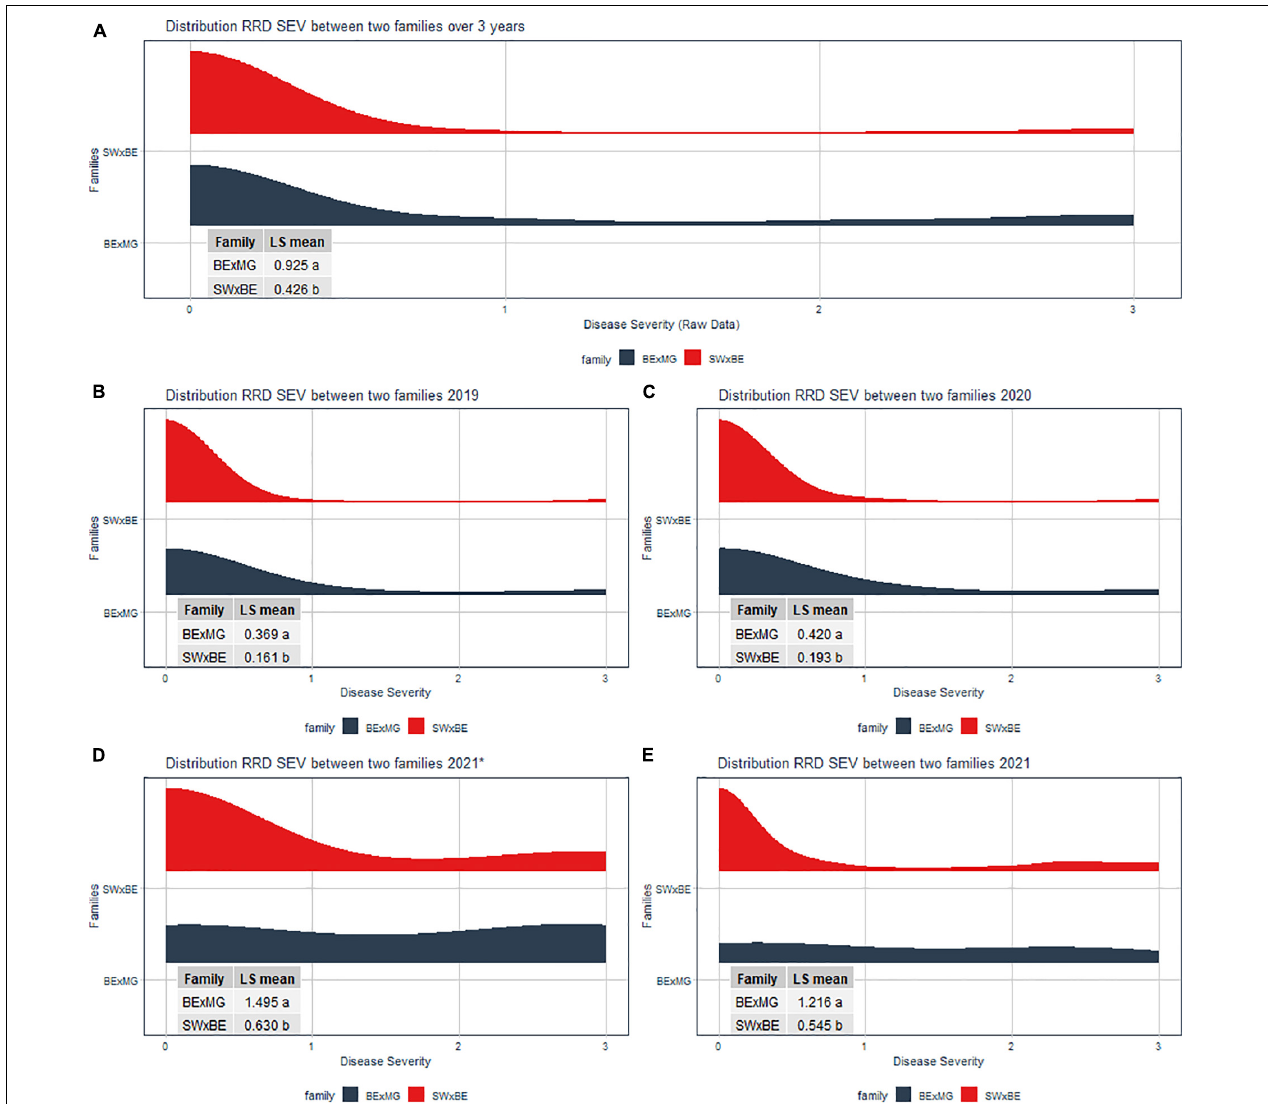
FIGURE 1 | Half violin plots of the raw rose rosette disease (RRD) severity ratings over 3 years separated by the two families. Least-squared means were compared via a t -test. The panes of the violin plots are (A) RRD severity distribution of over all 3 years (2019 to 2021), (B) RRD severity distribution in 2019, (C) RRD severity distribution in 2020, (D) RRD severity distribution in September 2021, and (E) RRD severity distribution in November